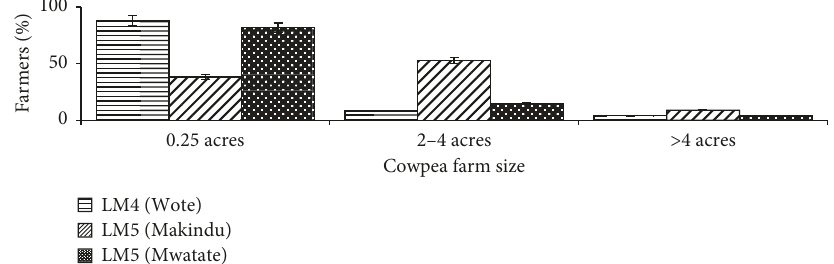
Figure 3: Percentage of farmers growing cowpea seeds in various farm sizes in various agroecological zones in Makueni and Taita Taveta during the 2016 short rains.